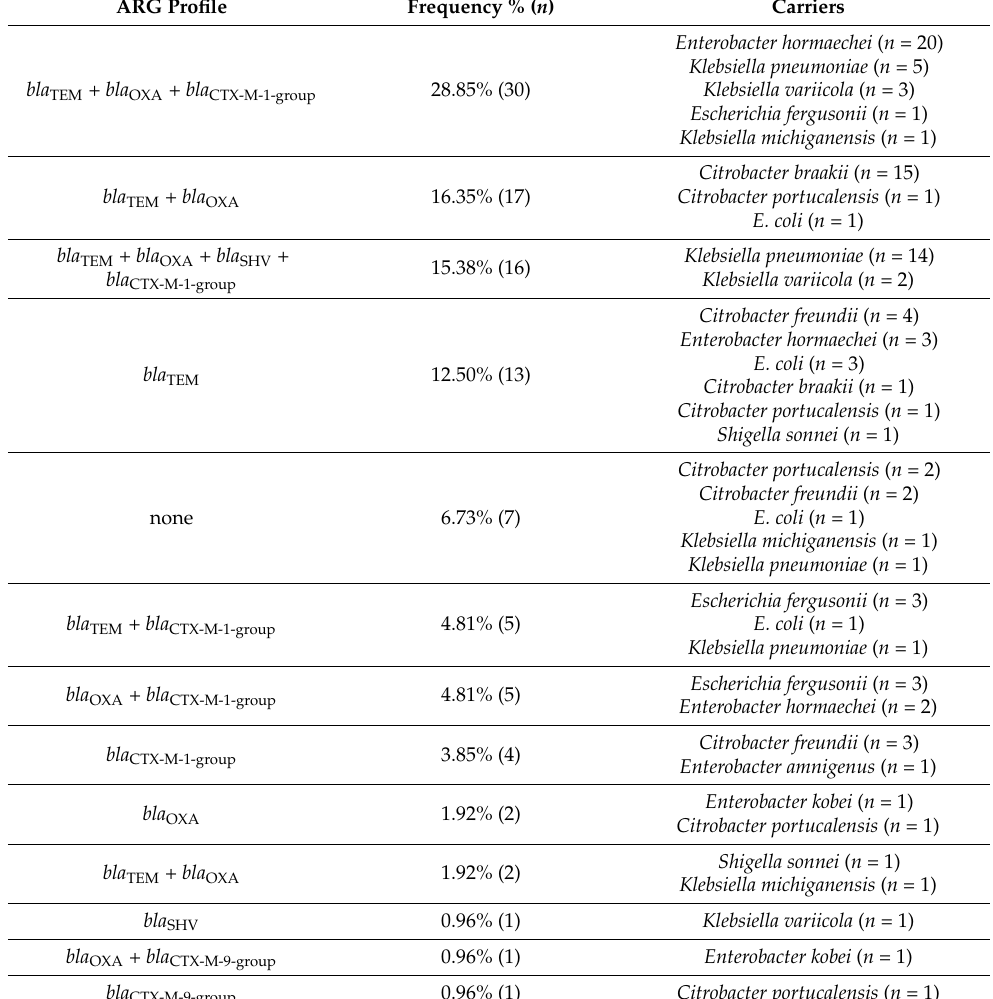
Table 1. Co-occurrence of ARG profiles in ESBL+ bacterial